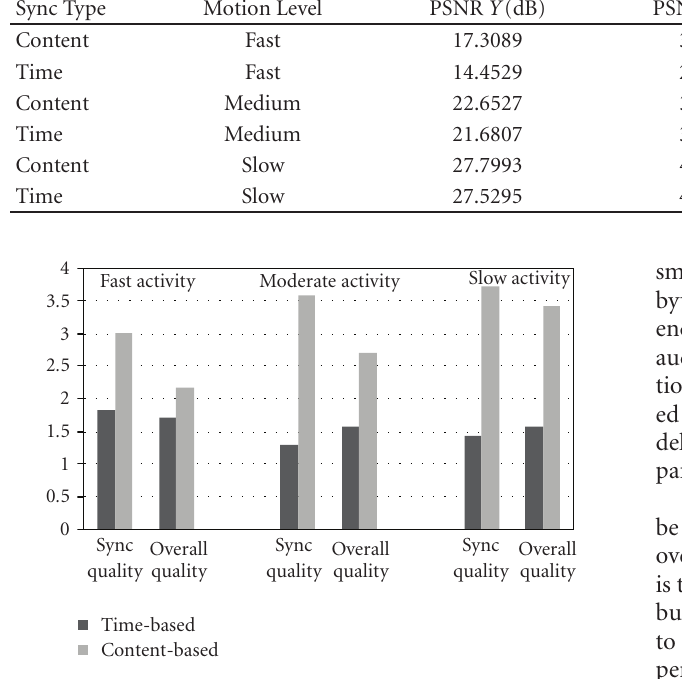
Figure 8: Perceived synchronization and overall